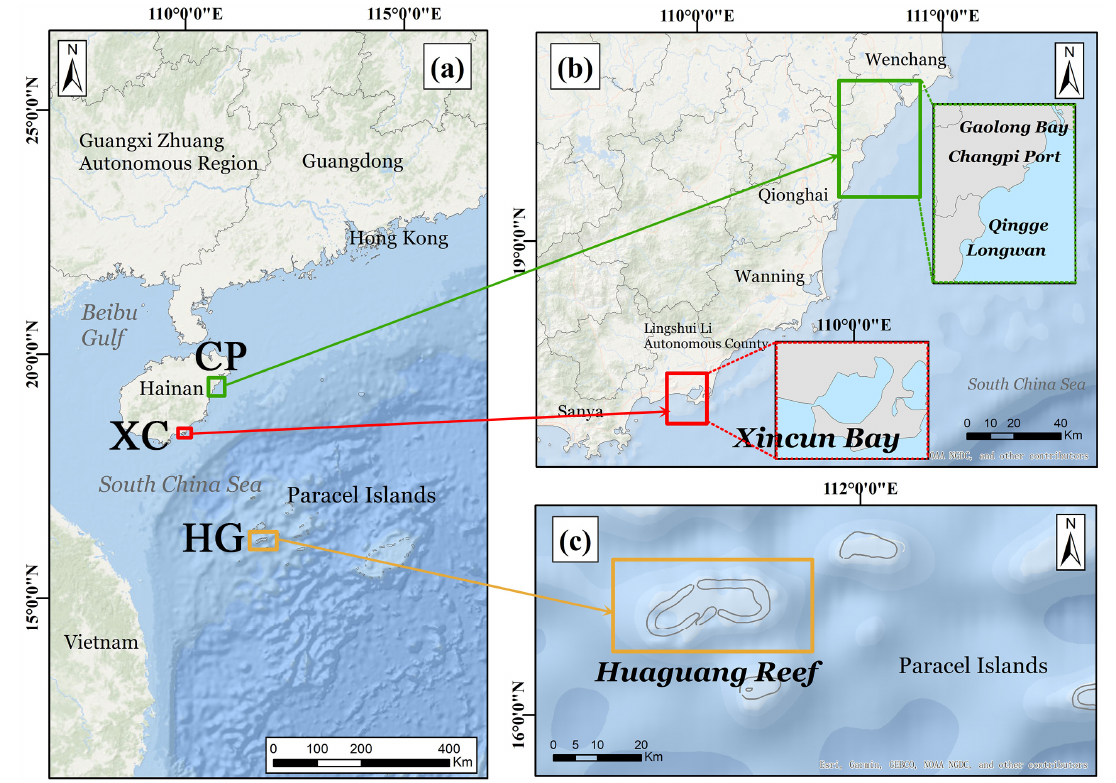
Figure 9. The locations of three regions, with the green box for Changpi Port (CP), red box for Xincun Bay (XC), and yellow box for Huaguang Reef (HG). The base map is obtained from the World Ocean Base from Esri. ( a ) is the location for the three regions, ( b ) is the enlarged location for CP and XC, and ( c ) is the enlarged location for HG.